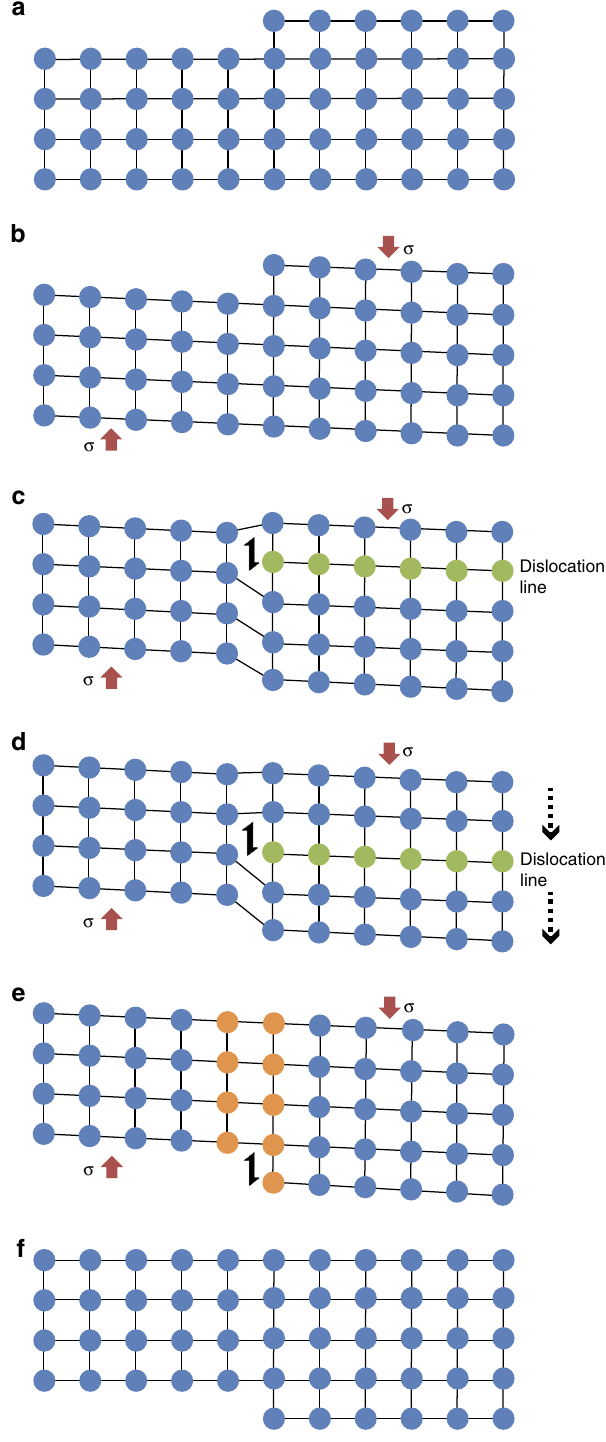
Fig. 1 Schematic representation of a dislocation in a crystal lattice. Here an edge dislocation forms and propagates through the lattice for simplicity, but screw dislocations are also common. The stages show: a isostatic stress conditions, and no deformation; b differential stress applied, leading to elastic strain; c yielding occurs under applied stress, creating a dislocation; d the dislocation migrates under differential stress conditions; e the dislocation passes through, resulting in distortion and f upon return to isostatic stress conditions, elastic strain is recovered. Dislocations that have passed through as in f leave a shape change but no internal distortion, however, signi fi cant densities of dislocations stranded within the lattice at stages c – d give rise to macroscopic lattice distortion as documented